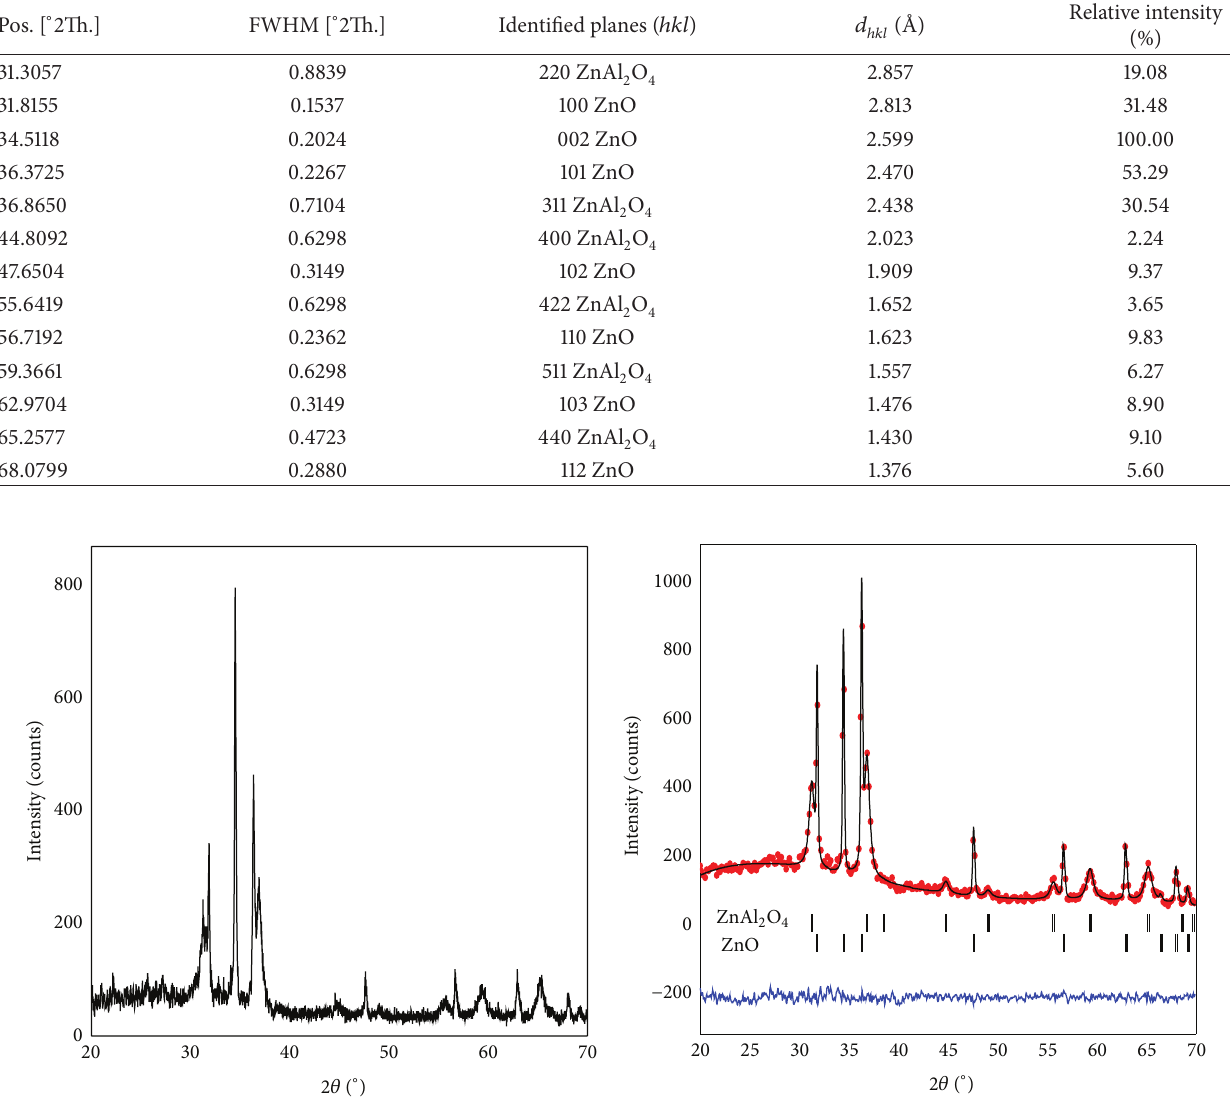
O nanocomposite films (annealed at 700 ∘ C). 2 4